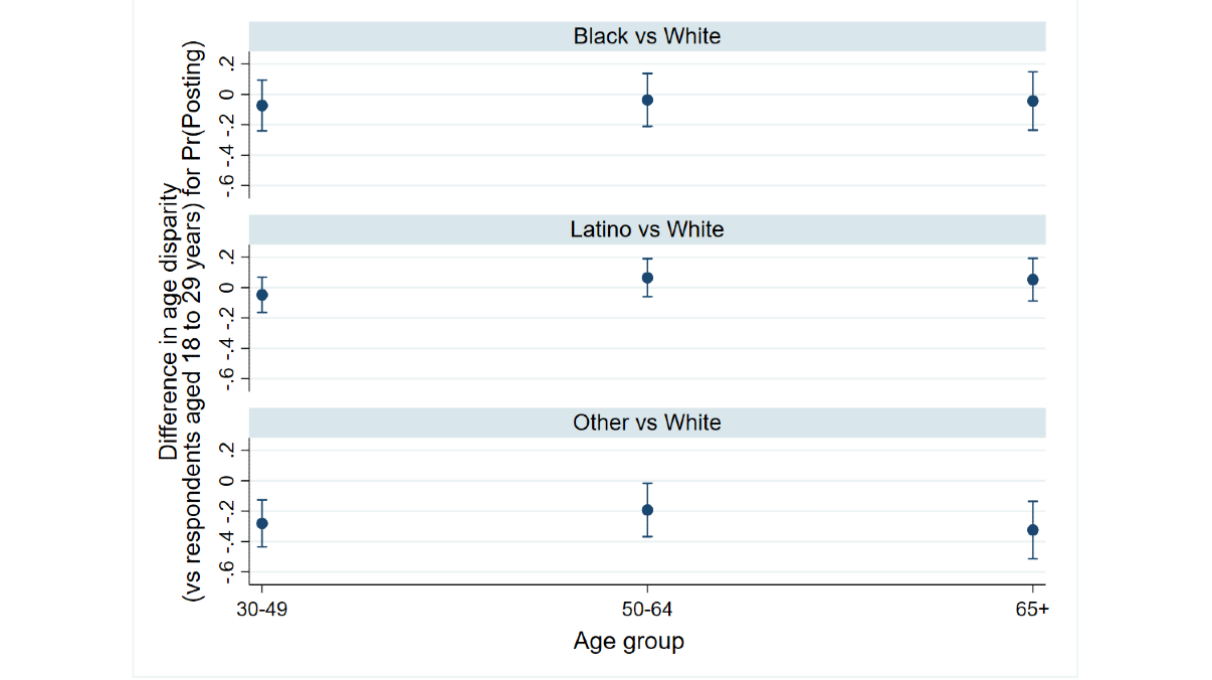
Figure 4. Differences in the age divide in posting (95% CI) among respondents who identified as black, Latino, or other races/ethnicities relative to respondents who identified as white. Pr(Posting): probability of